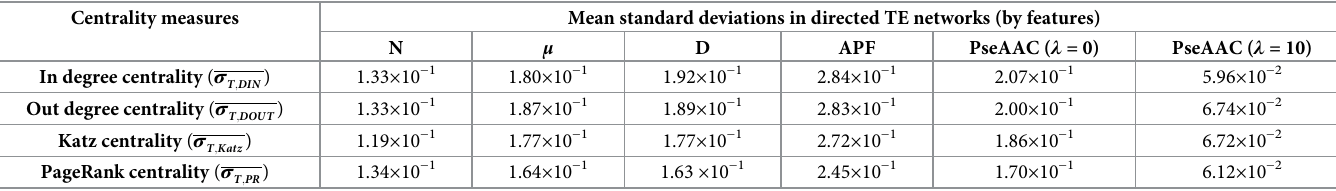
Table 4. The mean standard deviation results for the centralities of directed networks (SCOP). Centrality measures